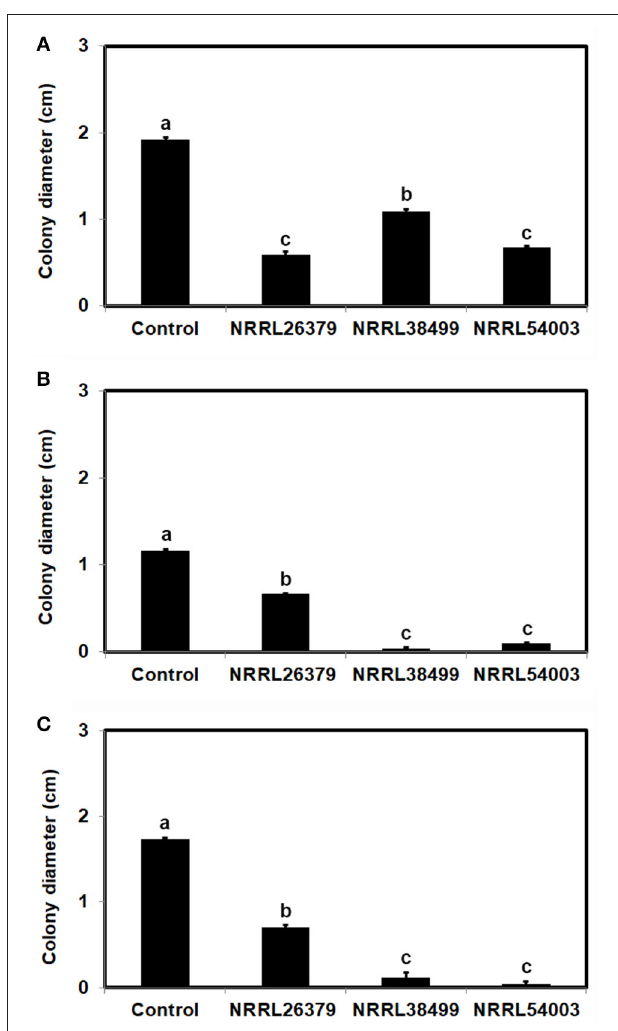
FIGURE 4 | Increased amount/activity of antifungal molecules secreted by T. virens in response to F. oxysporum VCs. T. virens strain G-41 inoculated on cellophane membrane overlaid on PDA was co-cultivated with three F. oxysporum strains as well as un-inoculated PDA (Control) for 40h. After removing the cellophane membrane with T. virens culture, a plug of (A) NRRL54003, (B) NRRL26379, or (C) NRRL38499 culture was inoculated. Colony diameters after 5 days of incubation are shown. Values shown correspond to the mean SD of data from three replicates. Different letters ± indicate significant differences based on Fisher’s test at P 0.05. =